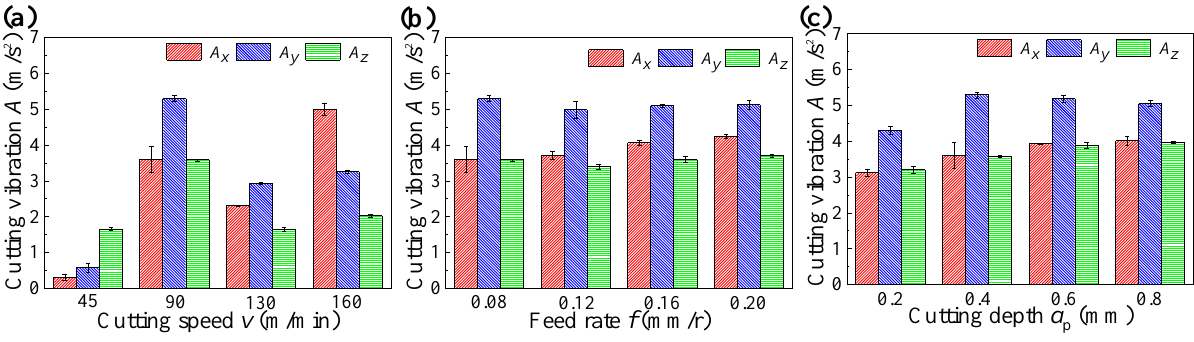
Figure 7. Cutting temperatures obtained under different cutting parameters: ( a ) cutting speed, ( b ) feed rate, and ( c ) cutting depth.